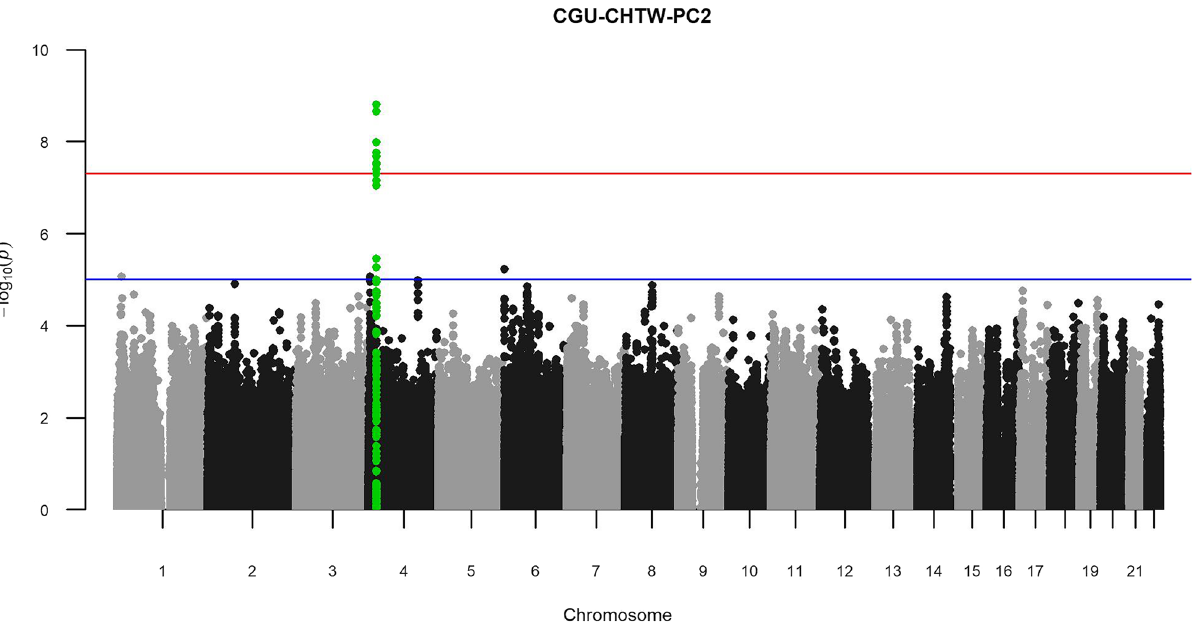
Figure 3. Manhattan plot for CGU-CHTW-PC2 showing KCNIP4 peak with higher significance than in the GWAS of CGU-PC1. The red line indicates the genome-wide significance threshold of 5 × 10 −8 , while the blue line indicates the suggestive threshold of 1 × 10 –5 . CGU serum creatinine, eGFR, and serum urea, CHTW cholesterol HDL-C ratio, HDL-cholesterol, triglyceride, and waist hip